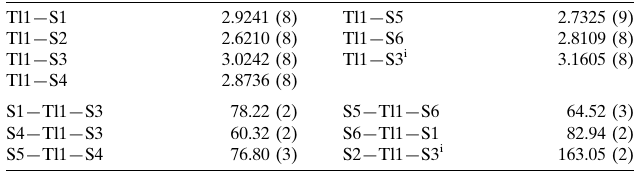
Selected geometric parameters (A˚ , (cid:2) ).